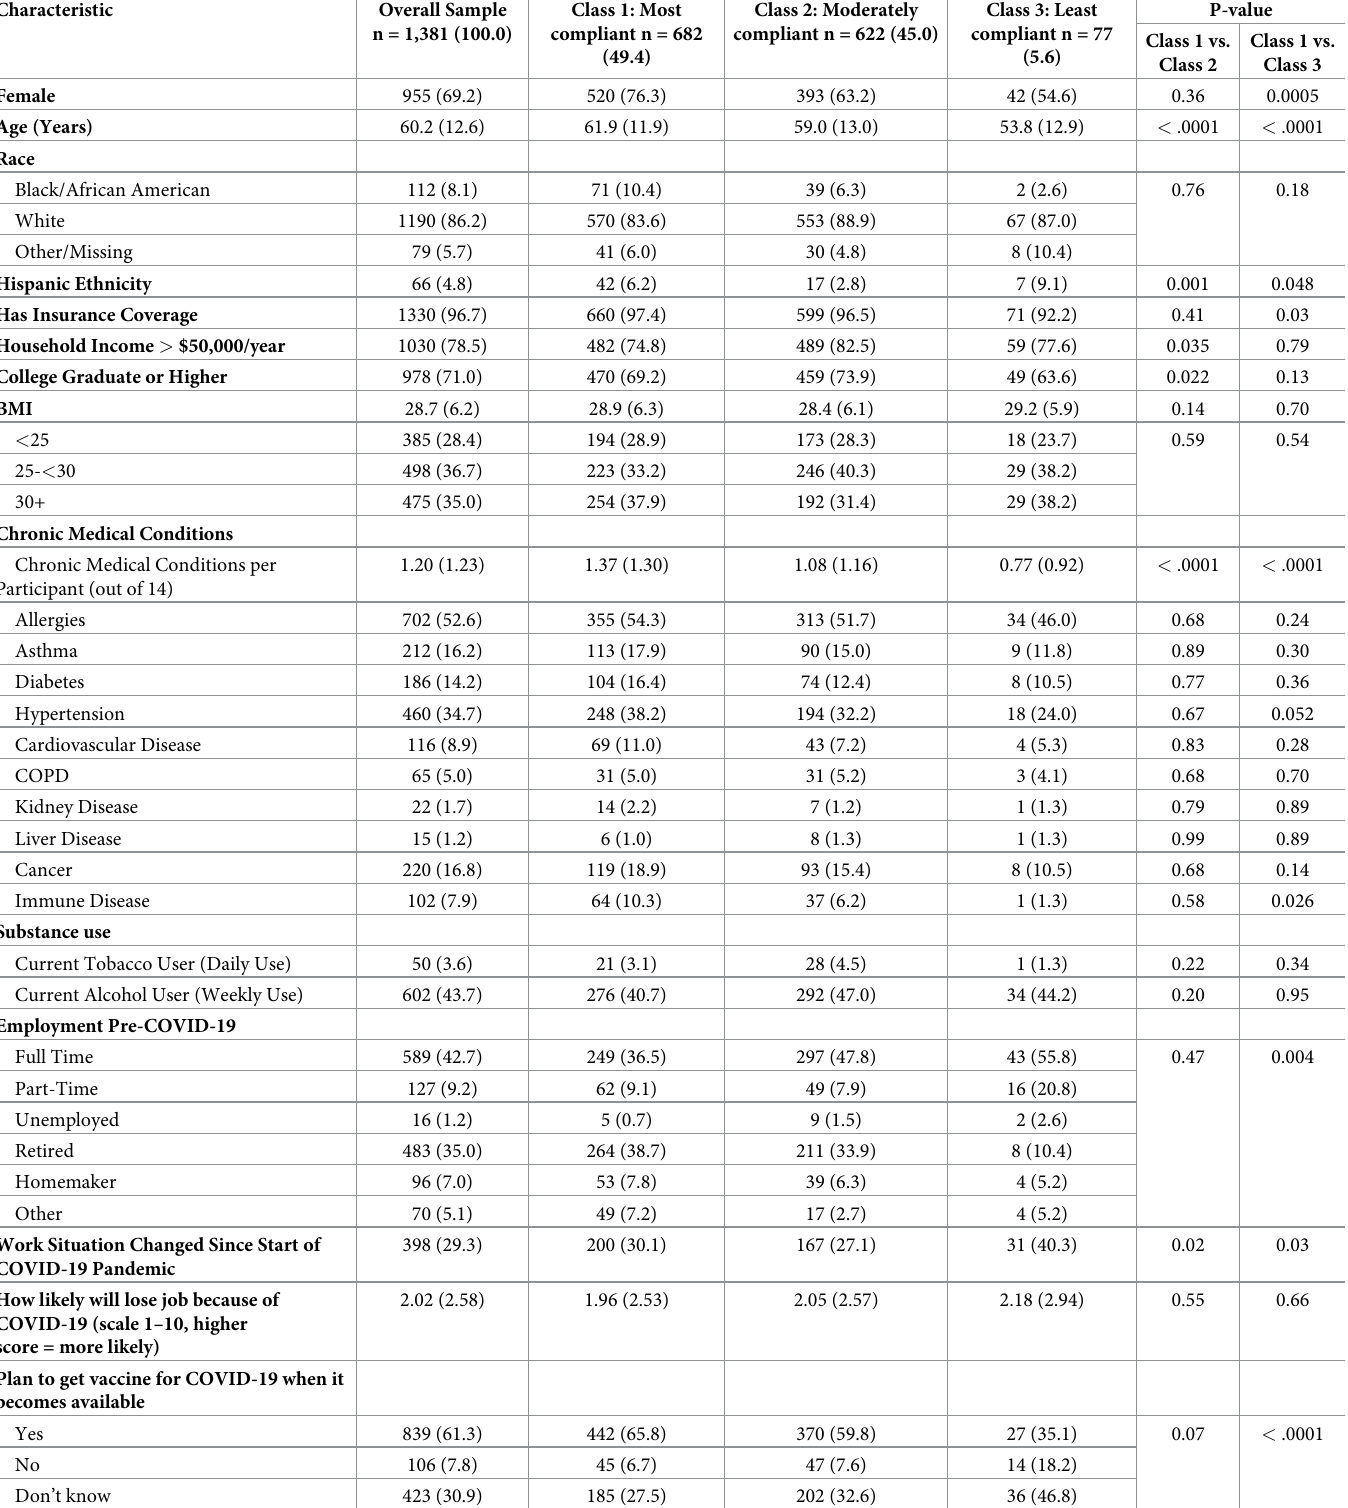
Table 2. Baseline demographic and clinical characteristics of participants overall and by compliance